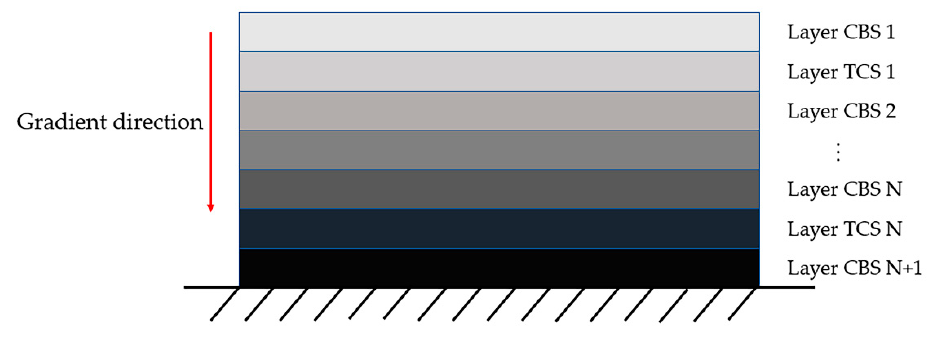
Figure 3. Configuration of the considered FGM.